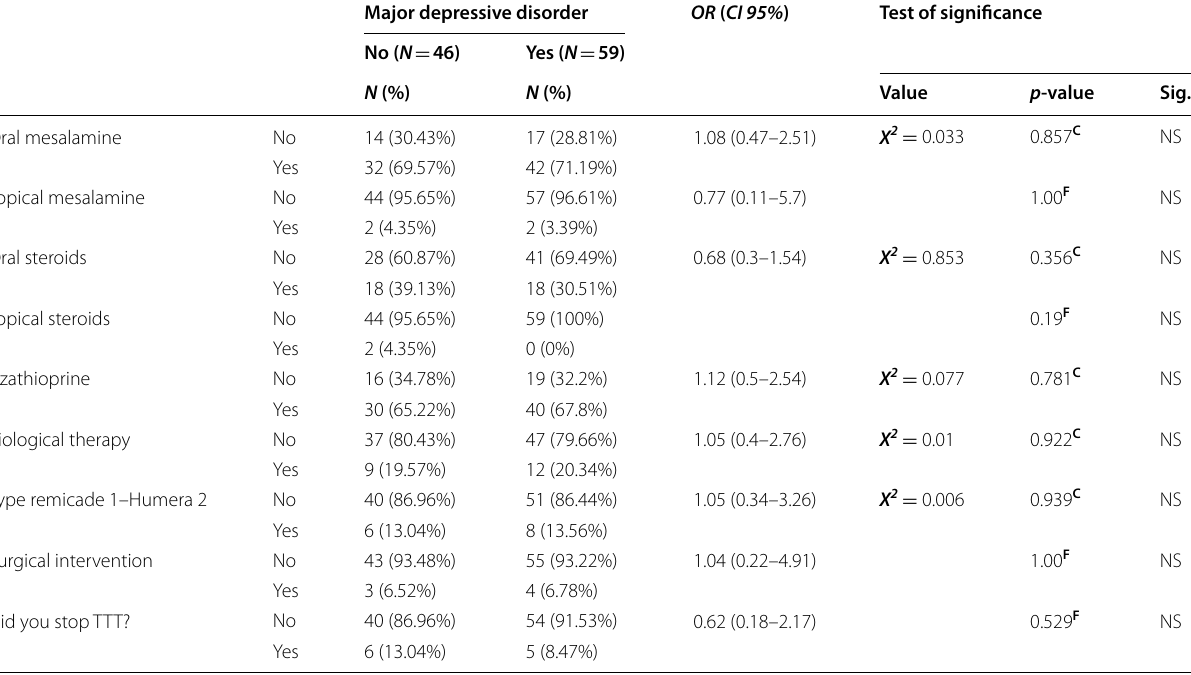
Table 8 Multivariable logistic regression analysis of the relationship between treatment types received by the patient and major depressive